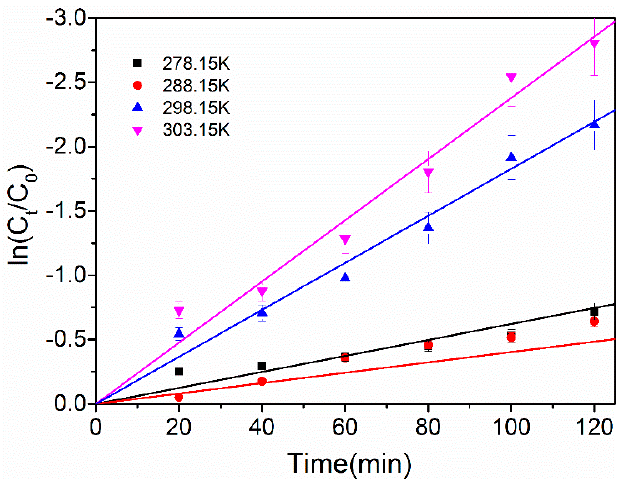
Figure 8. Linear fitting curves of 4-CP dechlorination at different temperatures, I = 6 mA, pH = 2.30.